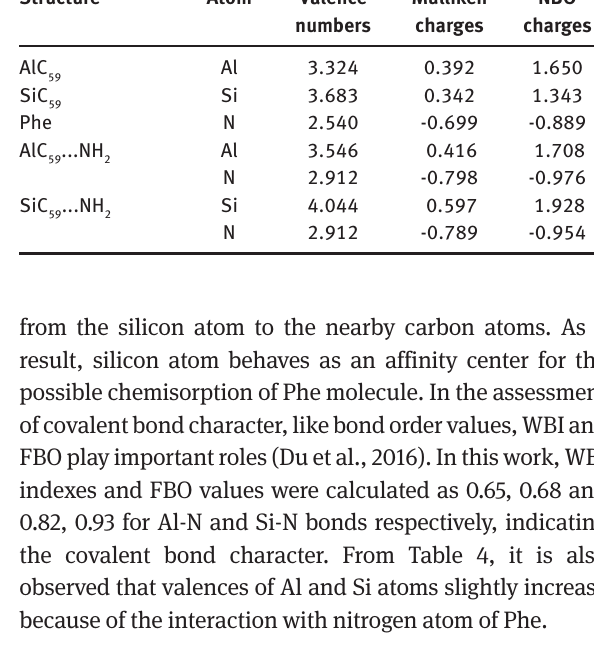
Table 3: Internuclear distances of the investigated systems. Interatomic distances